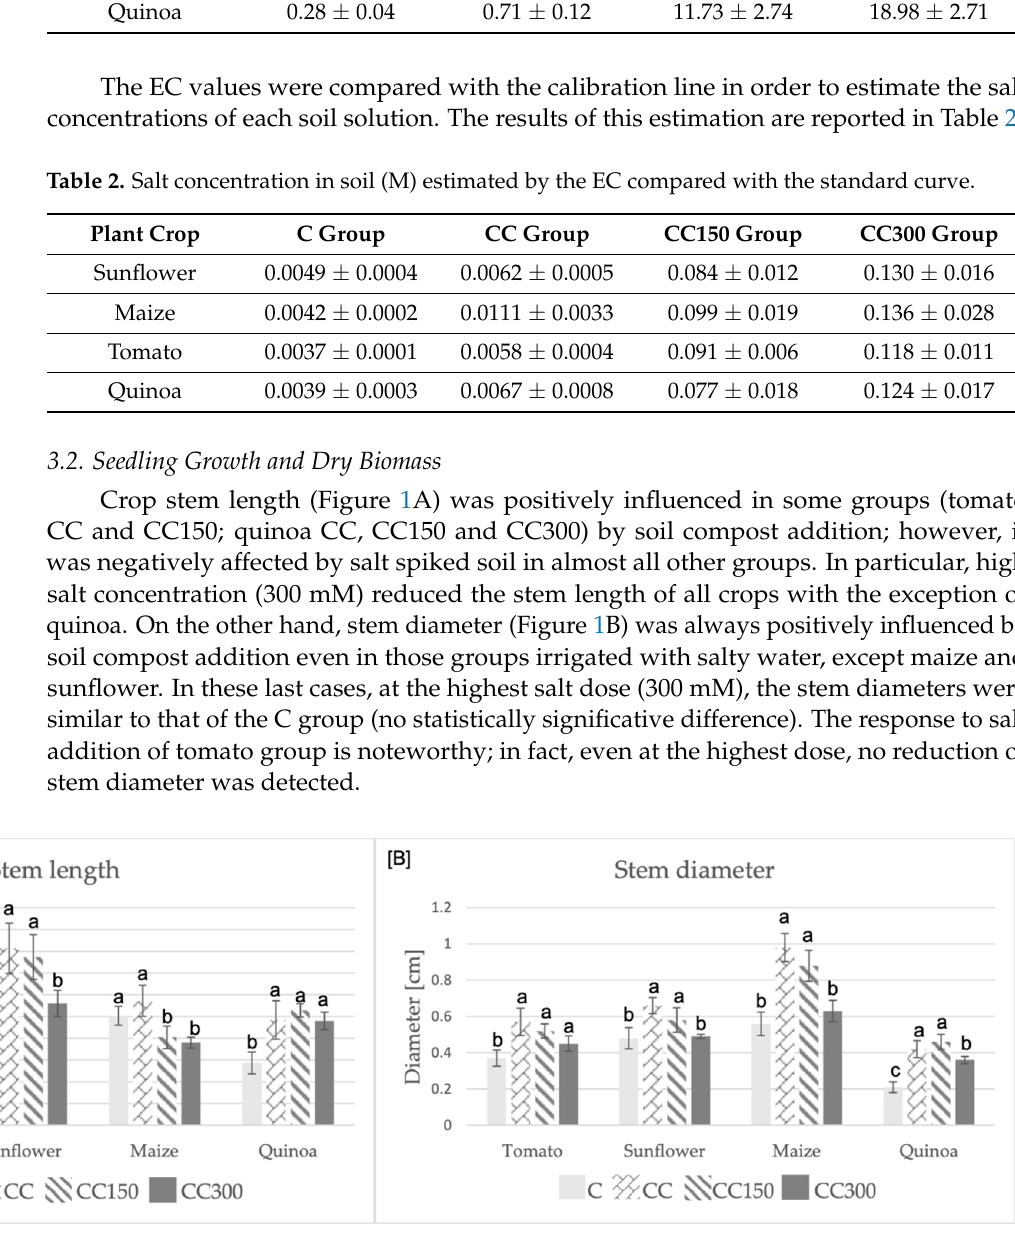
Figure 1. Stem length ( A ) and stem diameter ( B ) of the four crops undergone the different experimental conditions. Statistical significance assayed for p = 0.05. The comparison was performed within the plant species. The letters: a, b, c, indicate the statistically significant differences.